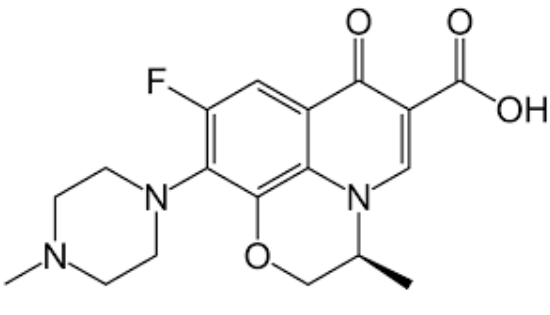
Figure 1. Chemical structure of the